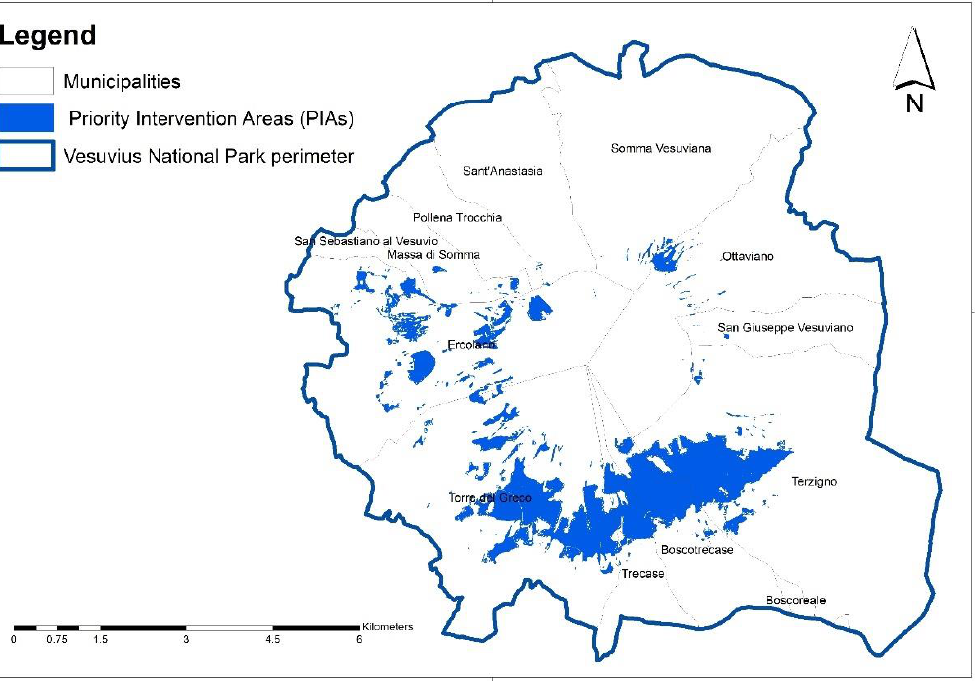
Figure 5. The Priority Intervention Areas (PIAs). Non English contents are place names.